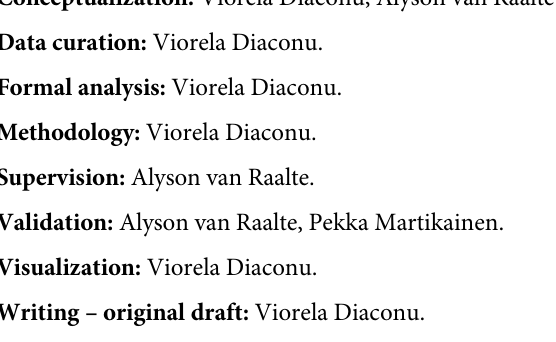
S1 Fig. Proportion of the population exposed to the risk of dying by occupational class and gender, Finland, 1971-2017. S2 Fig. Proportion of survivors to M by sex, G7 countries since 1970. (TIF) S3 Fig. Modal age at death, M , estimated from one- and two-dimensional P -spline smooth age-at-death distributions, by occupational class and sex, Finland 1971-2017. (TIF) S1 Appendix. Estimation of occupation-specific modal age at death, M , and conditional life expectancies at age 65 and 75, e , e from P -spline smooth occupation-specific density 65 75